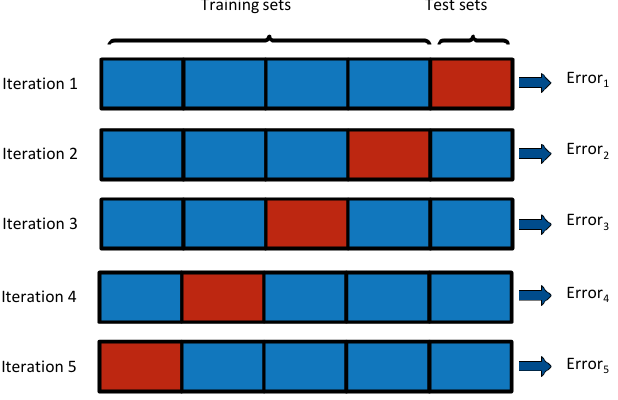
Figure 7. K-fold cross-validation with k =